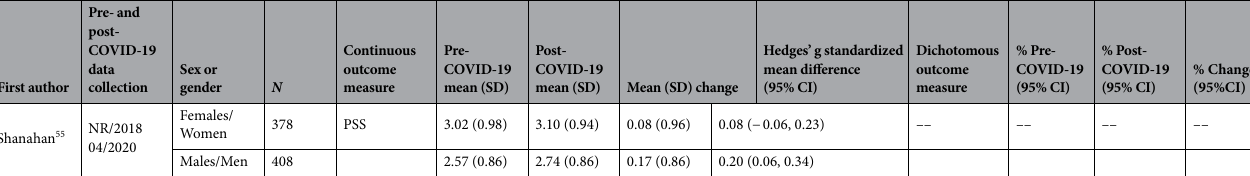
Table 2. Outcomes from included studies by sex or gender. DASS-21 Anxiety = Depression, Anxiety, and Stress Scale—Anxiety subscale; DASS-21 Depression = Depression, Anxiety, and Stress Scale—Depression subscale; DASS-21 Stress = Depression, Anxiety, and Stress Scale—Stress subscale; GAD-7 = Generalized Anxiety Disorder-7; GHQ-12 = General Health Questionnaire-12; MHI-5 = Mental Health Index-5; PANAS-NA = Positive and Negative Affect Schedule—Negative affect subscale; PROMIS Anxiety = Patient- Reported Outcomes Measurement Information System—Anxiety subscale; PROMIS Depression = Patient- Reported Outcomes Measurement Information System—Depression subscale; PSS = Perceived Stress Scale; SCAS-C = Spence Children’s Anxiety Scale—Child; SCL-90-R = Symptom Check List-90 Revised; SMFQ = Short Mood and Feelings Questionnaire; SMFQ-C = Short Mood and Feelings Questionnaire—Child Version; WEMWBS = Warwick Edinburgh Mental Wellbeing Scale. a Positive Hedge’s g sizes and increases in proportions above a threshold indicate worse mental health in COVID-19 compared to pre-COVID-19. Effects for measures where high scores = positive outcomes were reversed to reflect this. b Number included in fixed 2019 outcomes. d Based on estimate from fixed effects regression model that estimates within-person